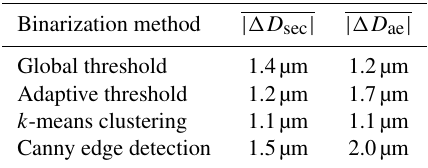
Table 1. Mean error of ice crystal sizing relative to operator- labeled image for different binarization methods in a sample im- age. | (cid:49)D sec | for diameter of smallest enclosing circle, | (cid:49)D ae | for area-equivalent